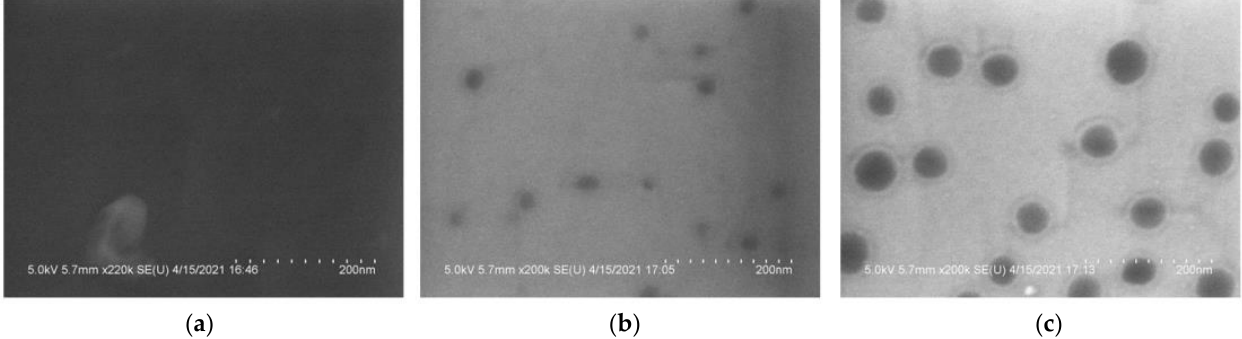
Figure 5. SEM photographs of the mirrors with a 4.5 nm SiN x protection film: ( a ) non-treated with O 2 plasma; ( b ) treated with O 2 plasma for 1 min; ( c ) treated with O 2 plasma for 40 min.